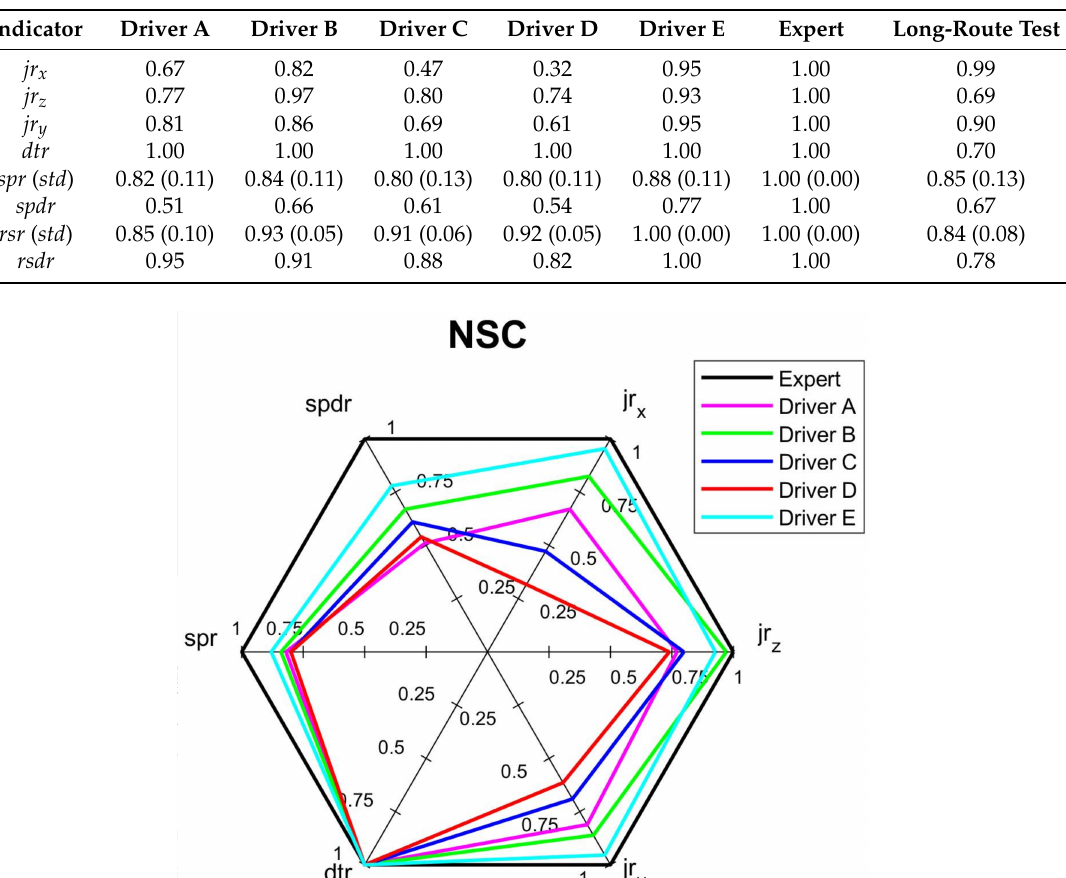
Figure 10. Spider diagram for safety criterion of short routes ( dtr indicator is not distinct due to short time of the test).